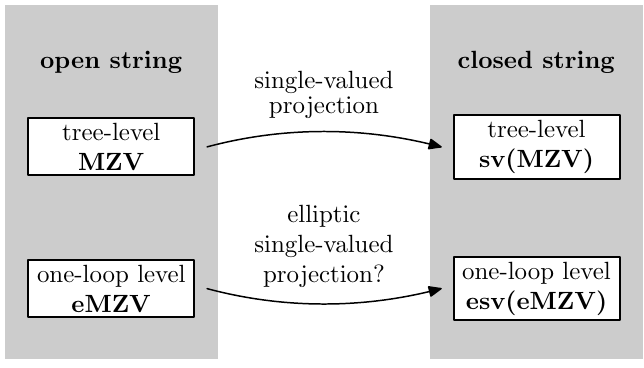
Figure 1 . Context of a tentative generalization \esv" of the single-valued projection to genus one. be taken as a starting point to propose an analogous single-valued projection of elliptic multiple zeta values (eMZVs), see (cid:12)gure 1. Accordingly, we are going to describe